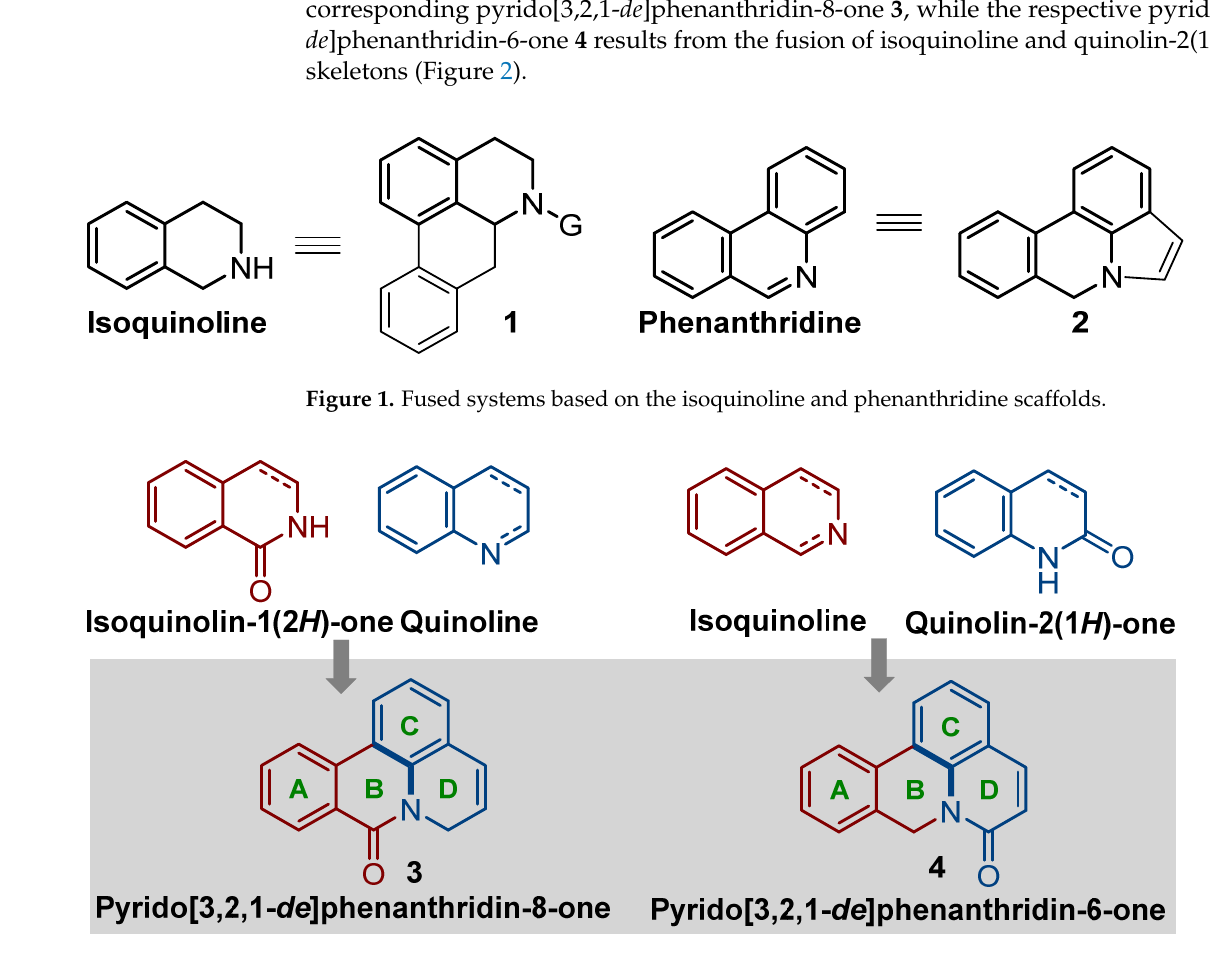
Figure 1. Fused systems based on the isoquinoline and phenanthridine scaffolds.